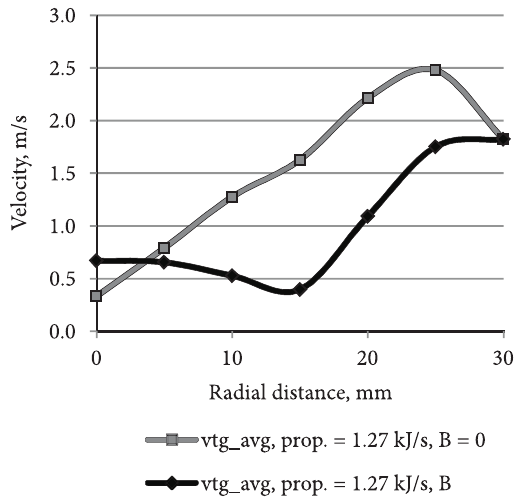
Fig. 9. Influence of propane-butane supply and magnetic field on swirling flow number